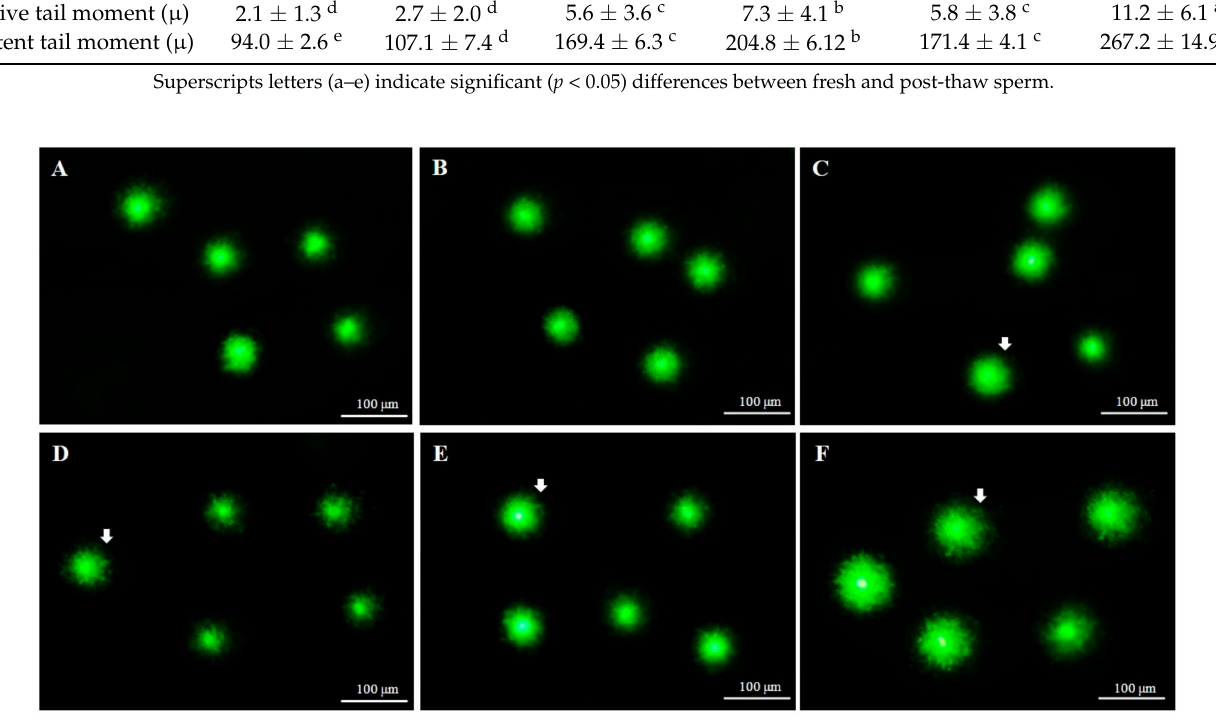
Figure 6. Comet images of fresh and cryopreserved sperm of Pacific abalone. Each comet indicates damaged or undamaged sperm DNA (arrow denotes migration of fragmented DNA from the nuclei of sperm). ( A ) Intact nuclei of fresh sperm. ( B ) Intact nuclei of sperm cryopreserved with 8% DMSO combined with 10 µ g/mL AFPIII. ( C ) Intact or slightly damaged nuclei of sperm cryopreserved with 8% EG combined with 10 µ g/mL AFPIII. ( D ) Intact or slightly damaged nuclei of sperm cryopreserved with 6% PG combined with 10 µ g/mL AFPIII. ( E ) Intact or slightly damaged nuclei of sperm cryopreserved with 2% GLY combined with 10 µ g/mL AFPIII. ( F ) Slightly damaged nuclei of sperm cryopreserved with 1 µ g/mL 2% MeOH combined with